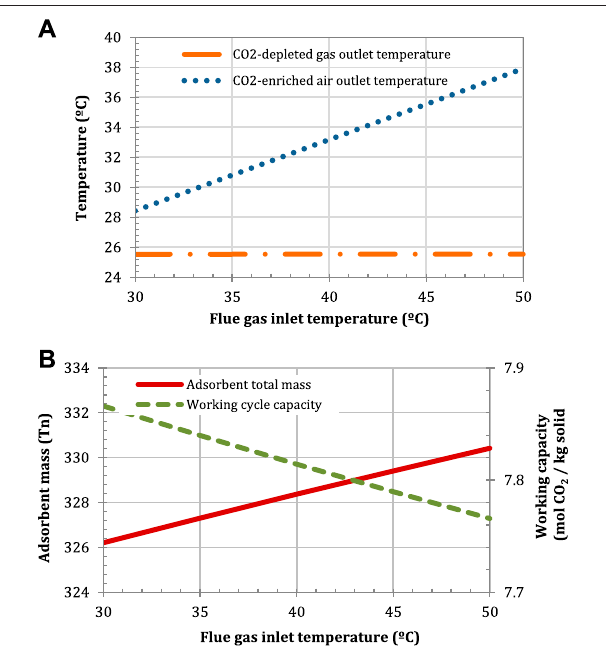
FIGURE14| Effectofthe fl uegasinlettemperatureon (A) theairand fl ue gas outlet temperatures, and (B) the adsorbent mass and the working capacity. Con fi guration: parallel S-EGR at 70% recirculation